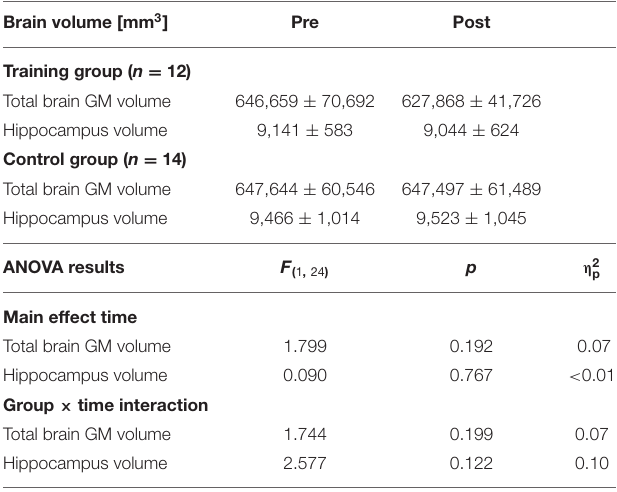
TABLE 5 | Main effects of time and interaction effects (group x time) in total brain gray matter volume and hippocampal